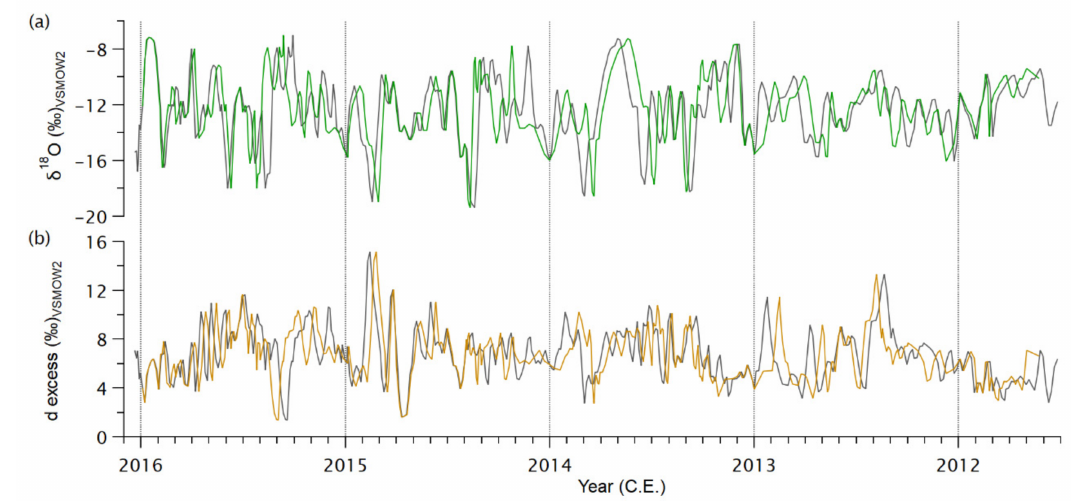
Figure 3. Comparison of the weighted age scale (coloured lines) of firn core OH-12 with the ALC-based (unweighted) age scale (grey lines) for ( a ) δ 18 O and ( b ) d